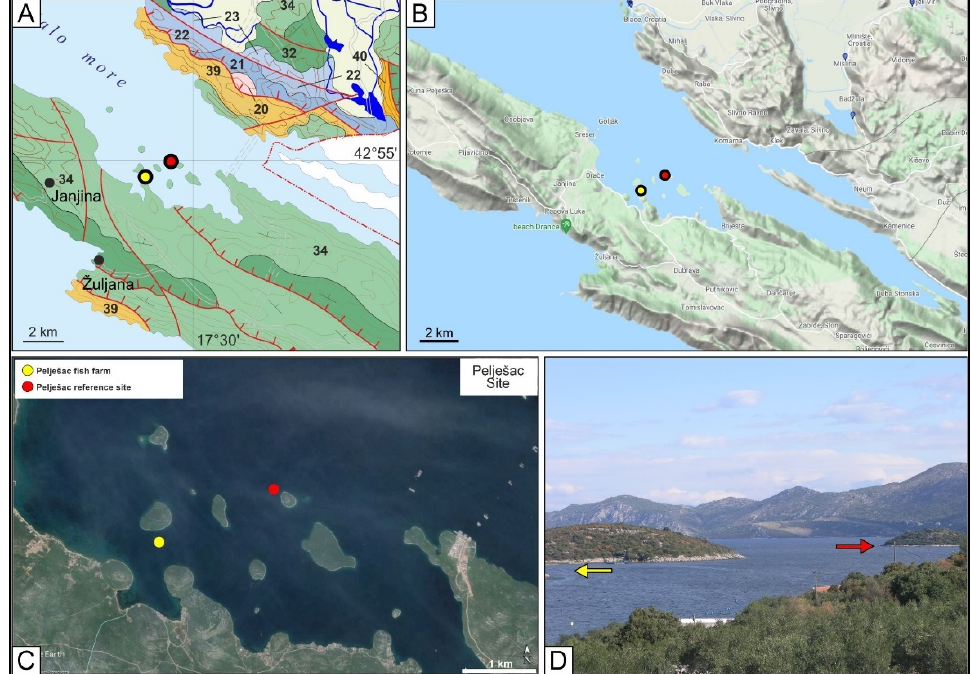
Figure 4. ( A ) Geological map of the Pelješac study site: 20—Triassic dolomites; 21–23—Jurassic lime- stones and dolomites; 32—Cretaceous limestones and dolomites; 34—Cretaceous limestones; 39— Paleocene-Eocene limestones; 40—Eocene-Oligocene carbonate deposits; blue lines—streams and rivers; blue areas—coastal lakes; red lines—main faults; dotted red line—border; thin brown lines— isohipses (after [35,36]). Red and yellow dots represent sampling locations. ( B ) Topographic map of the Pelješac study site wider area. Red and yellow dots represent sampling locations. ( C ) Location of the Pelješac fish farm and the Pelješac reference site (after Google Earth). Red and yellow dots represent sampling locations. ( D ) Pelješac sampling sites near carbonate islands. Yellow arrow points to fish farm cages; red arrow points to reference site.